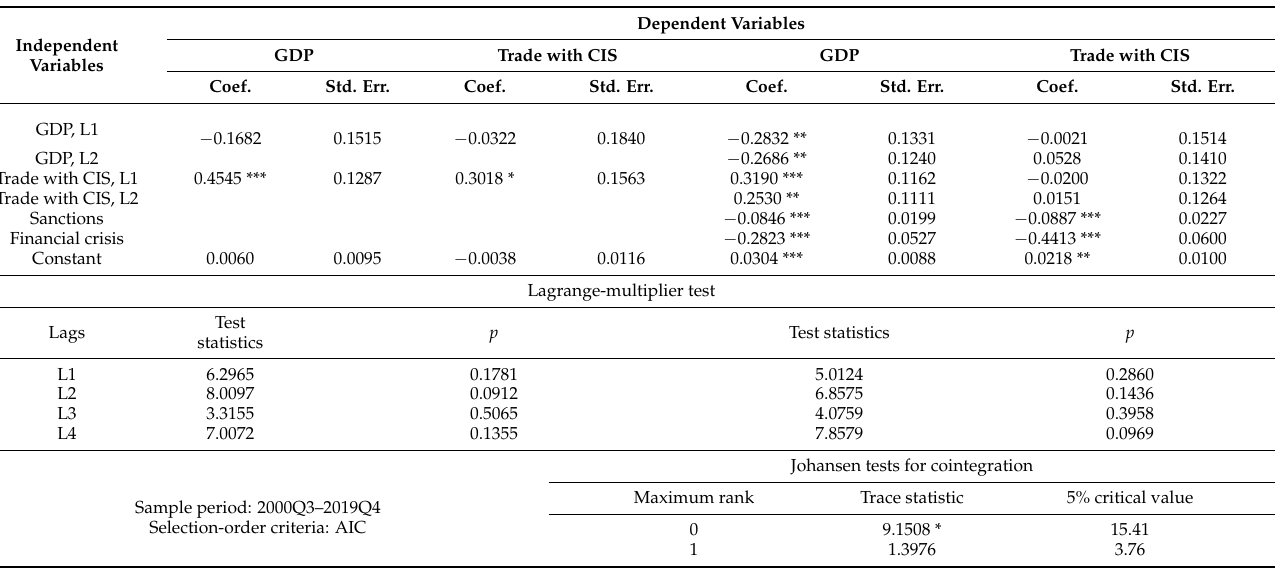
Table 7. VAR Model Estimation Results for Logarithmic Difference of Russian GDP and Trade with Other CIS